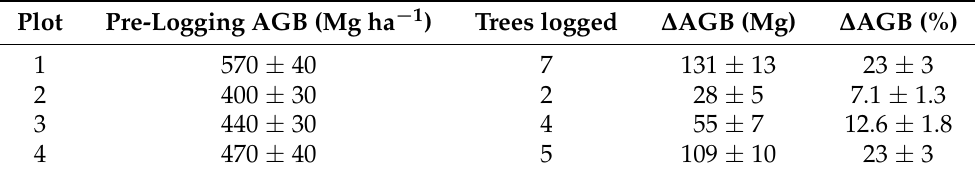
Table 2. Aboveground biomass (AGB) and AGB loss of four 1 ha selectively logged plots, measured by field inventory and terrestrial laser scanning